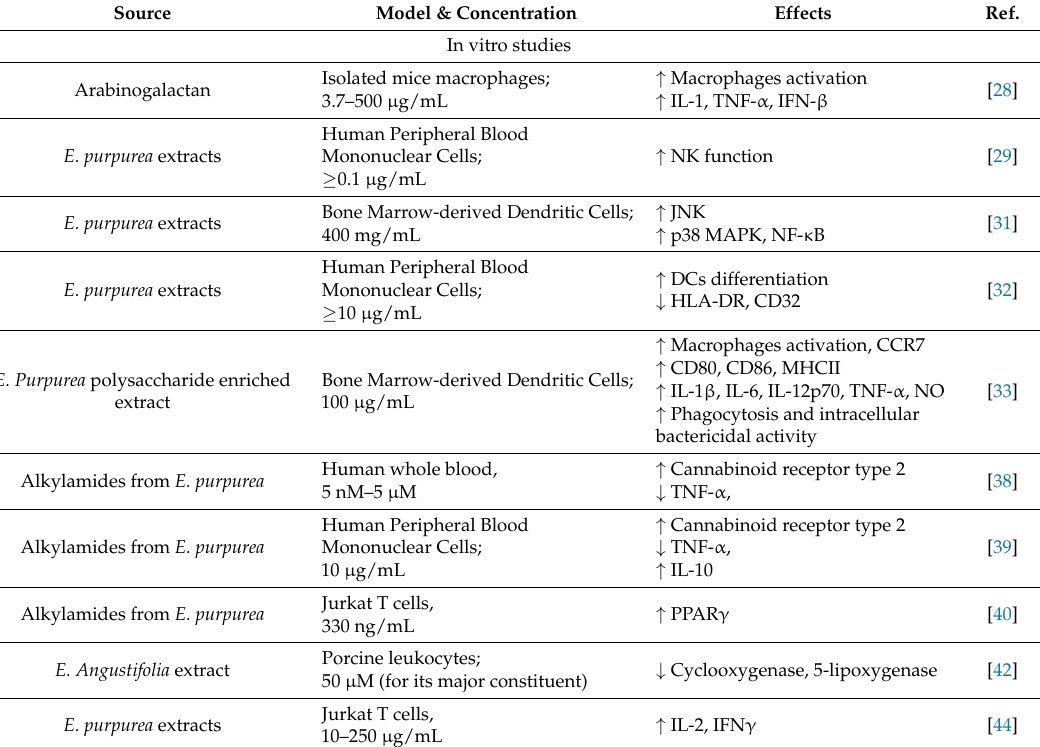
Table 1. Main significant immunomodulatory and antinflammatory effects of Echinacea in different in vitro